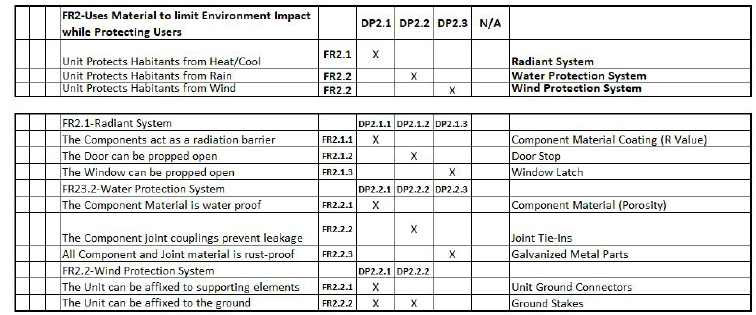
Figure 20. AD Top-Level Design Mapping of DPs for FR2.